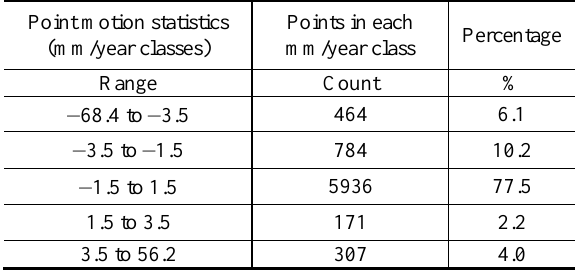
Table 1. Statistics of ground motion in five selected velocity classes according to